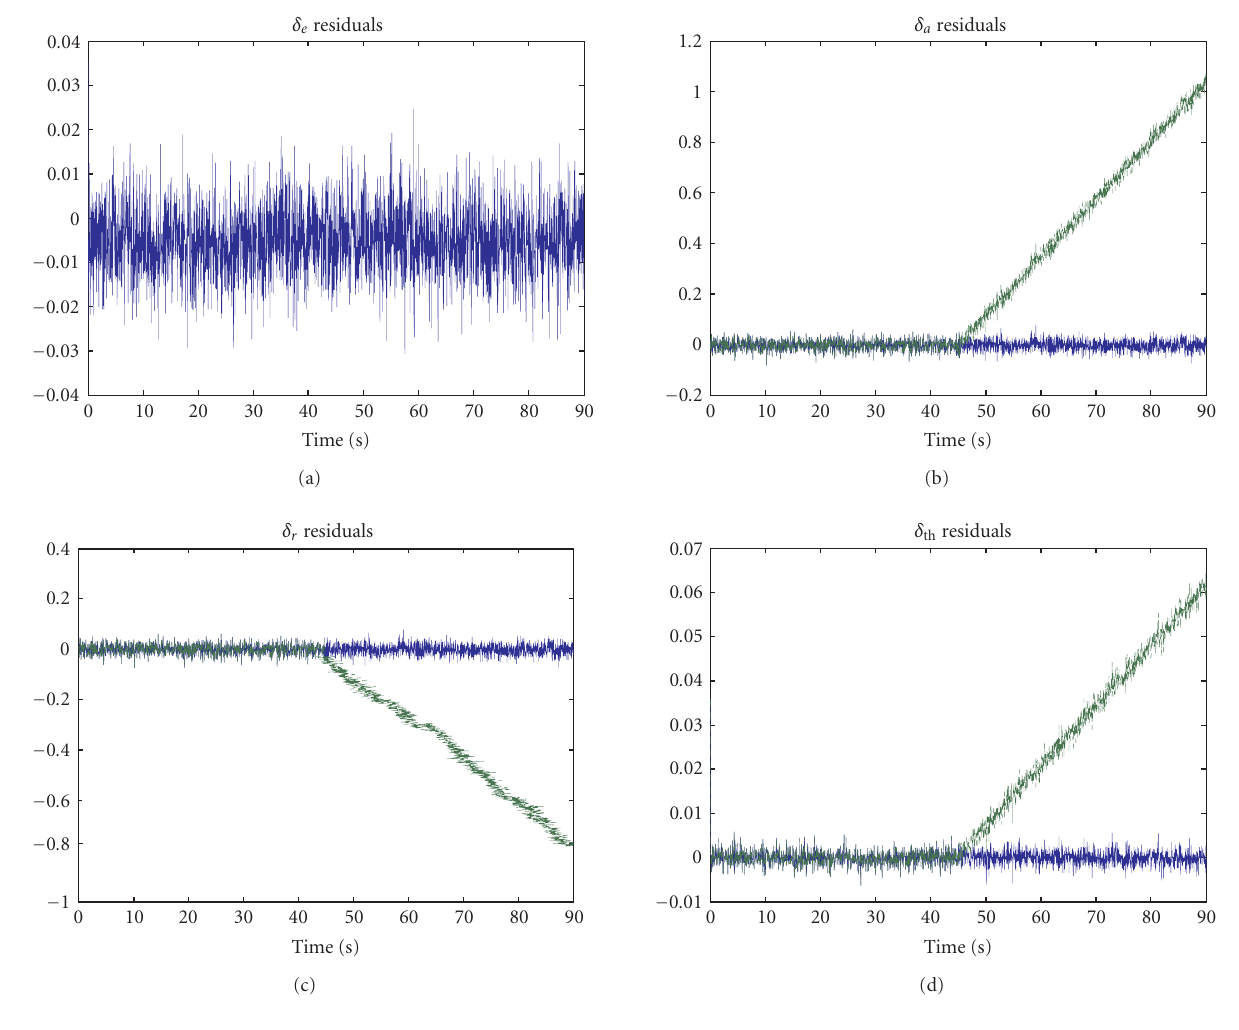
Figure 5: UIKF residuals with ramp fault.